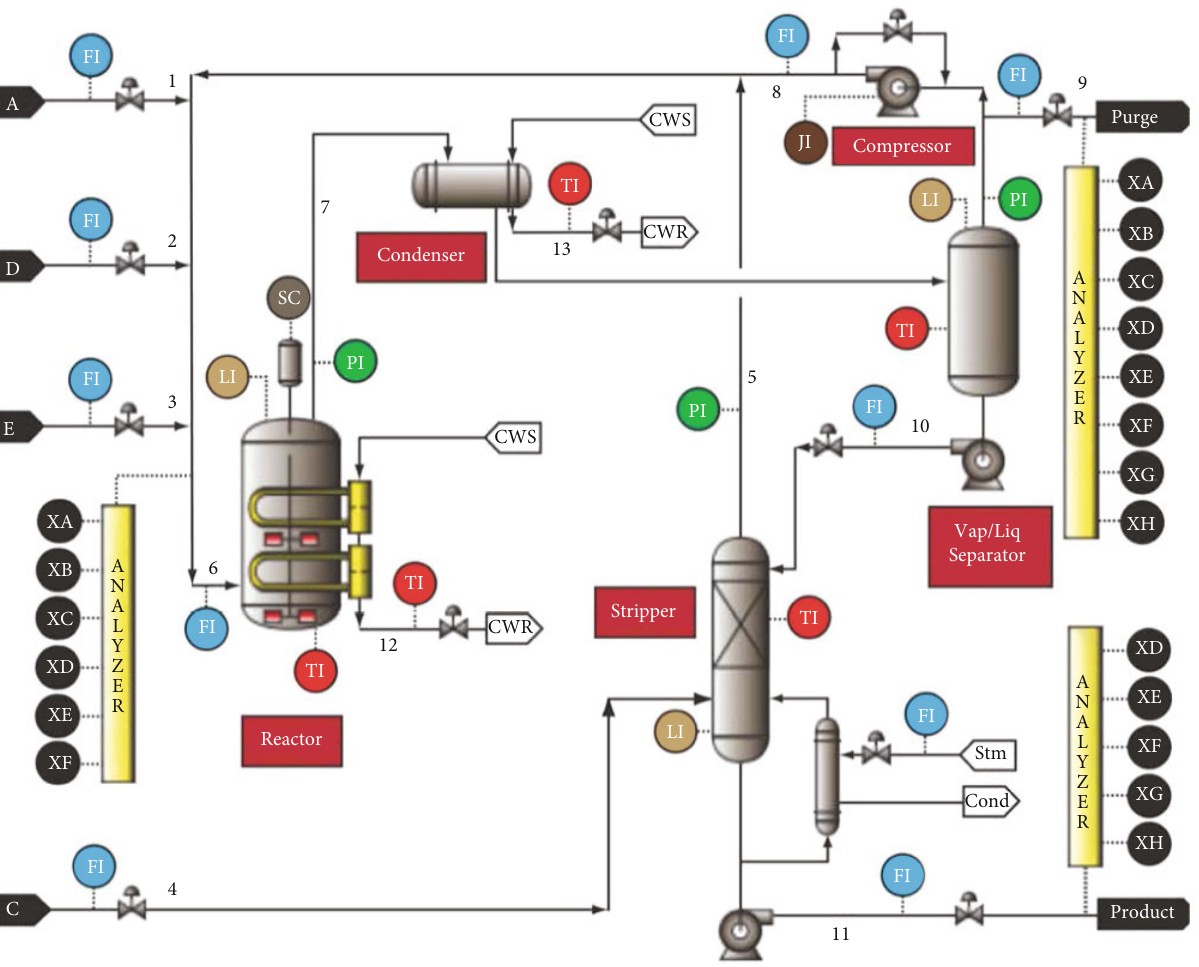
Figure 3: The diagram of the TE process.